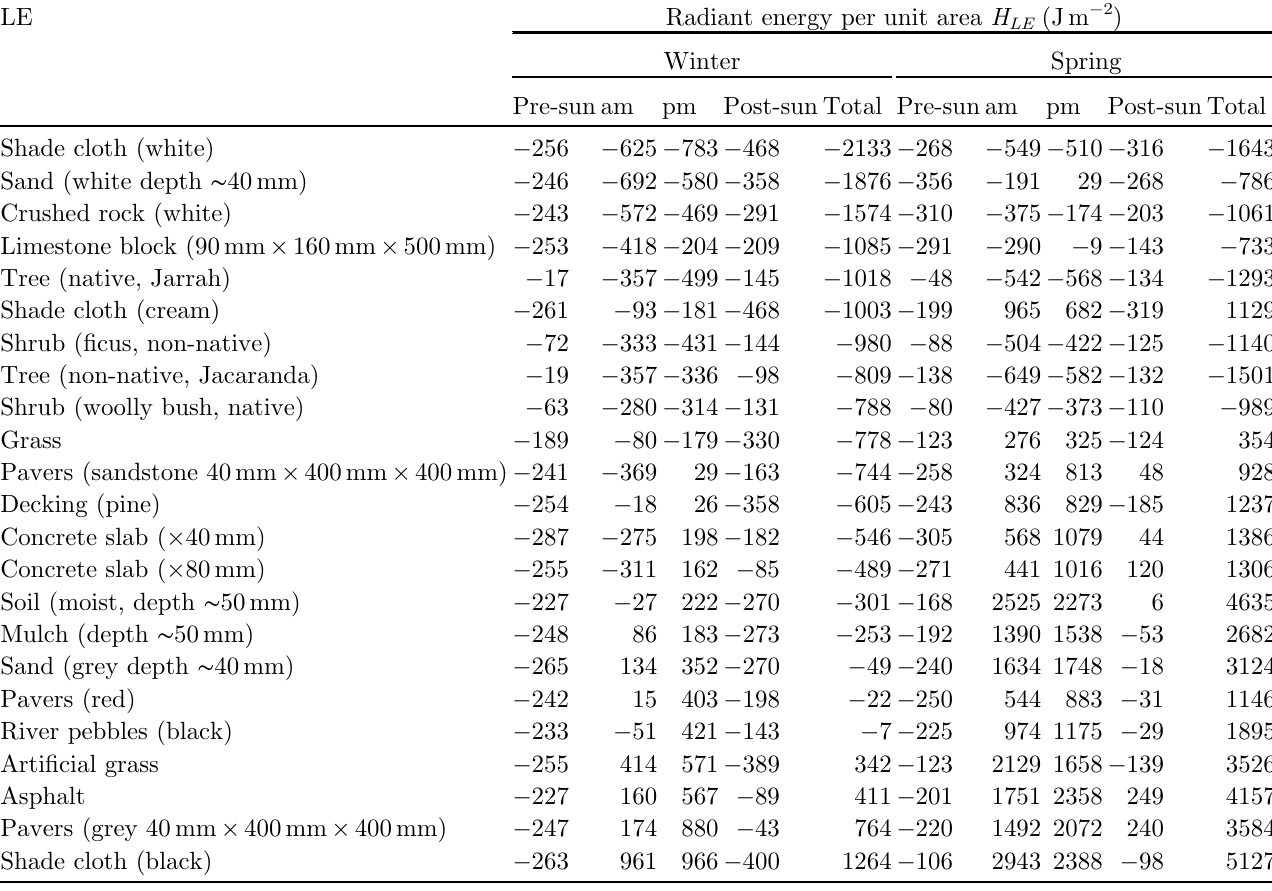
Table 1. List of normalised longwaveradiant energy per unit area for each LE. Data are sorted according to winter “ Total ” .